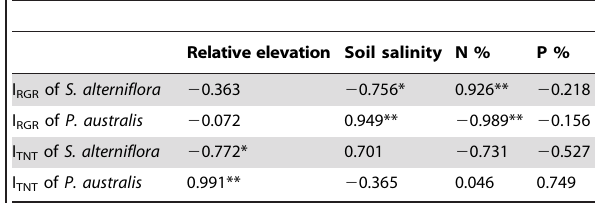
Table 4. Correlation of soil characteristics and the interaction strength (I)of S. alterniflora and P. australis .